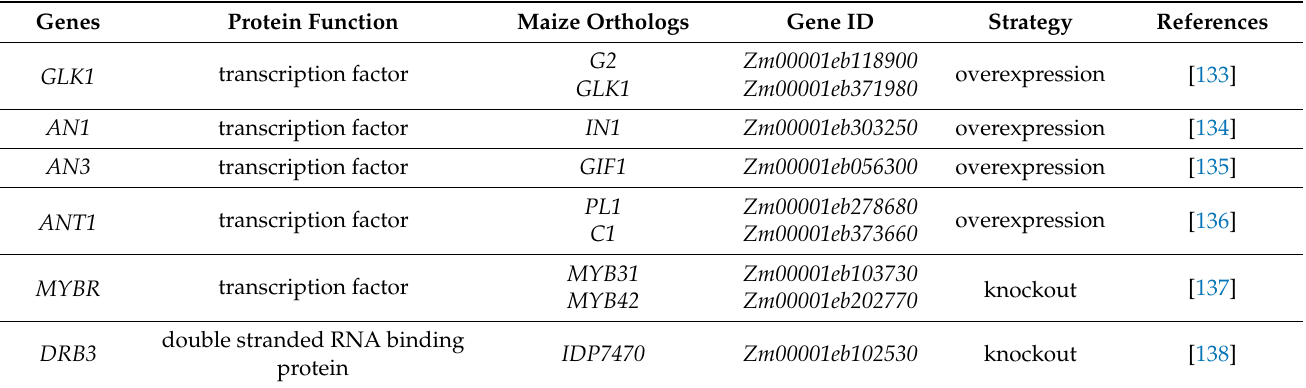
Table 6. List of potential gene resources for enhancing anthocyanin content in